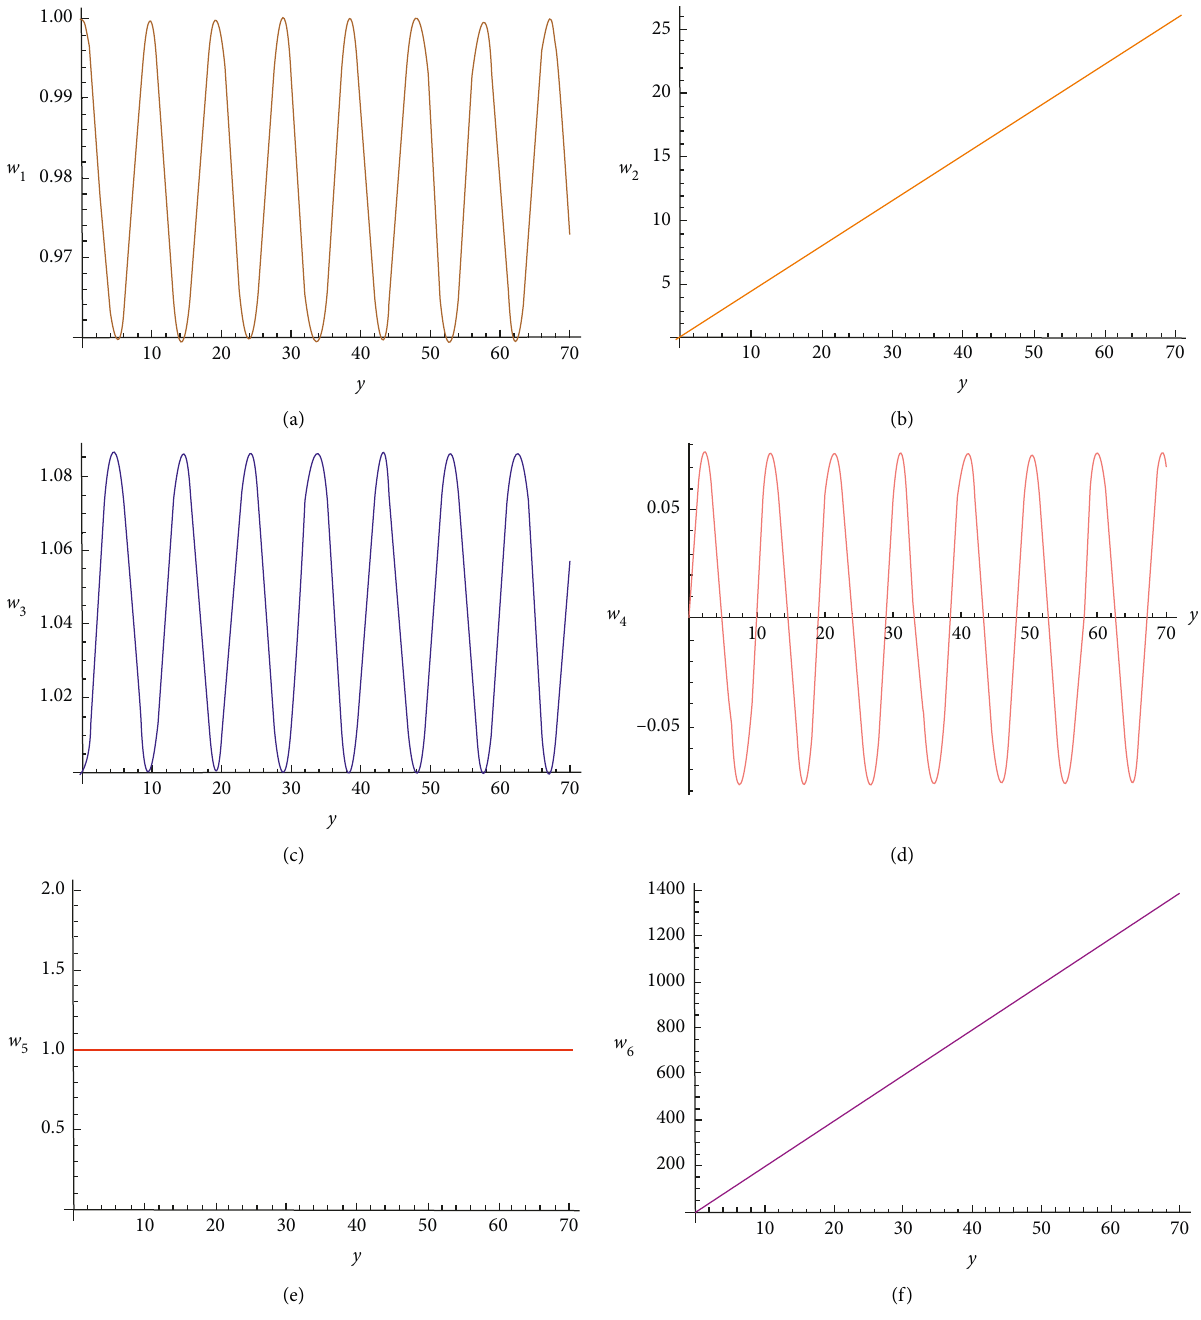
, ( i � 1 , 2 , . .. , 6 ) with distance of propagation y taking initial guess w i